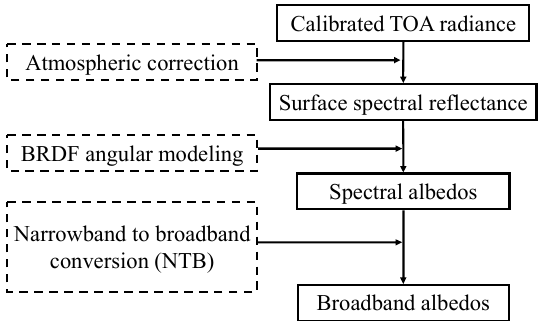
Figure 1. Algorithm for estimating broadband albedo using the kernel-driven BRDF model from spaceborne